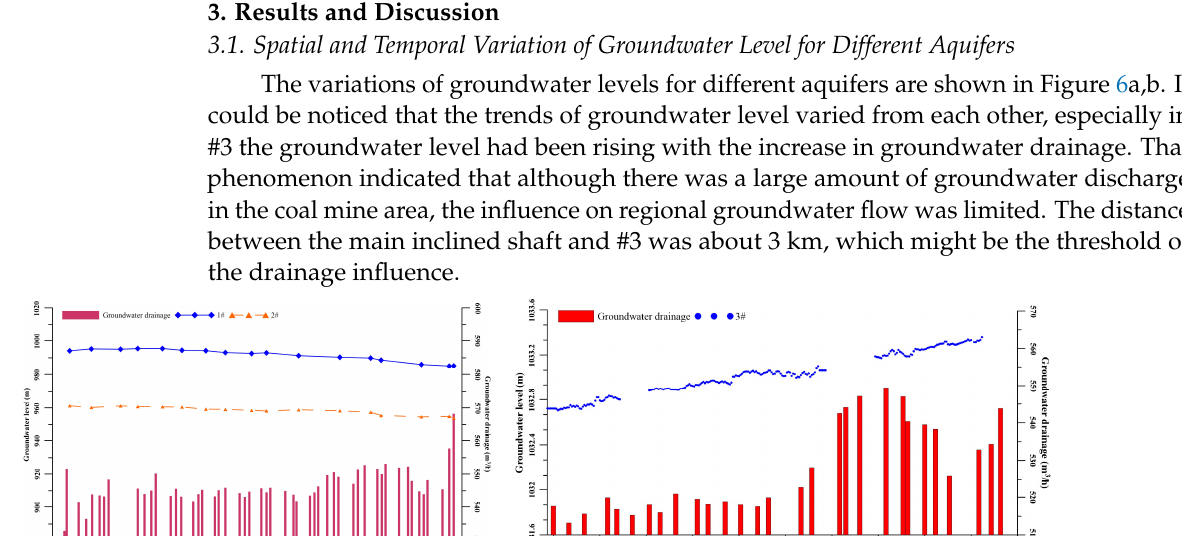
Figure 5. Time variations of groundwater drainage with coal mining in Hetaoyu Coal Mine.